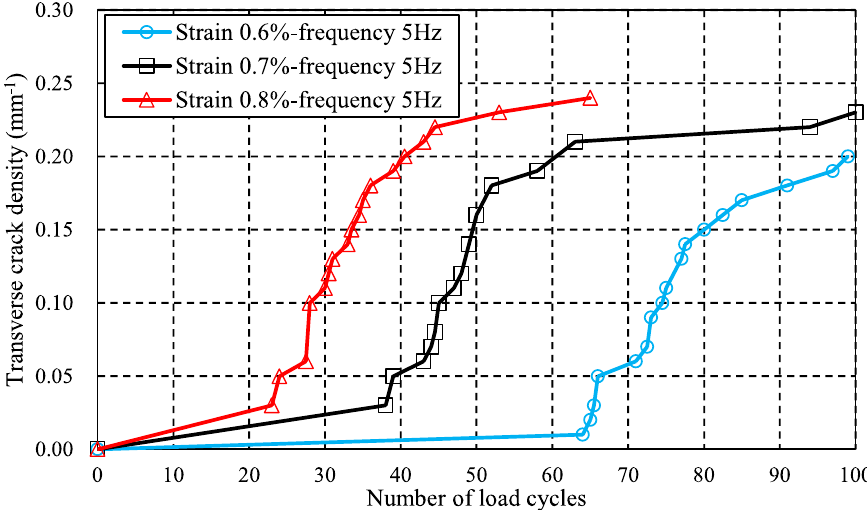
Figure 13. Effect of stress level on transverse crack density: strain boundary condition varies from 0.6% to 0.8% while the load frequency is fixed at 5 Hz.